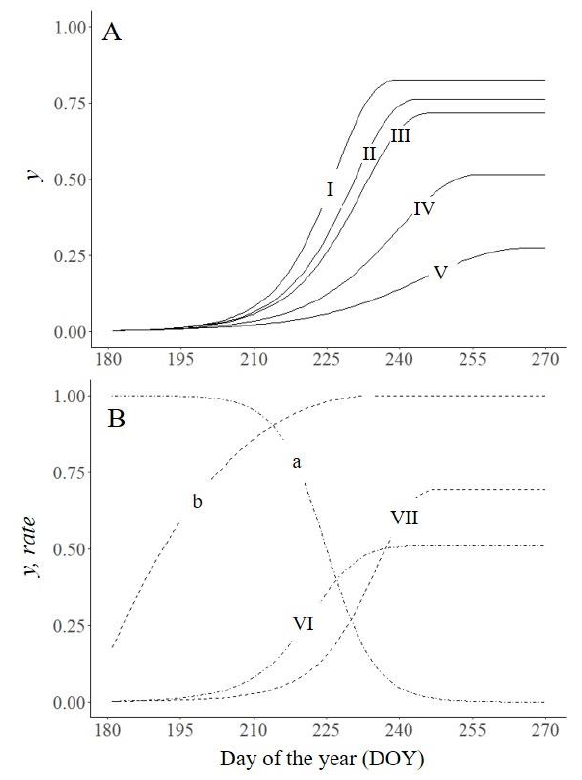
Figure 6. Effect on disease severity ( y ) of changes in plant resistance, either as horizontal ( A ) or ontogenic ( B ) resistance. I: control (susceptible plant), as in Figure 2 ( N = 0.8, I = 0.8, p = 6, i = 12); II, resistance due to increased latent period ( N = 0.8, I = 0.8, p = 8, i = 12); III, resistance due to reduced infectious period ( N = 0.8, I = 0.8, p = 8, i = 10); IV, resistance due to reduced sporulation ( N = 0.6, I = 0.8, p = 8, i = 10); V, resistance due to reduced infection efficiency ( N = 0.6, I = 0.6, p = 8, i = 10); VI: plant susceptibility decreased by age; VII: plant susceptibility increased by age; lines a and b are relative rates of susceptibility for lines VI and VII, respectively. Symbols are listed in Table 1.